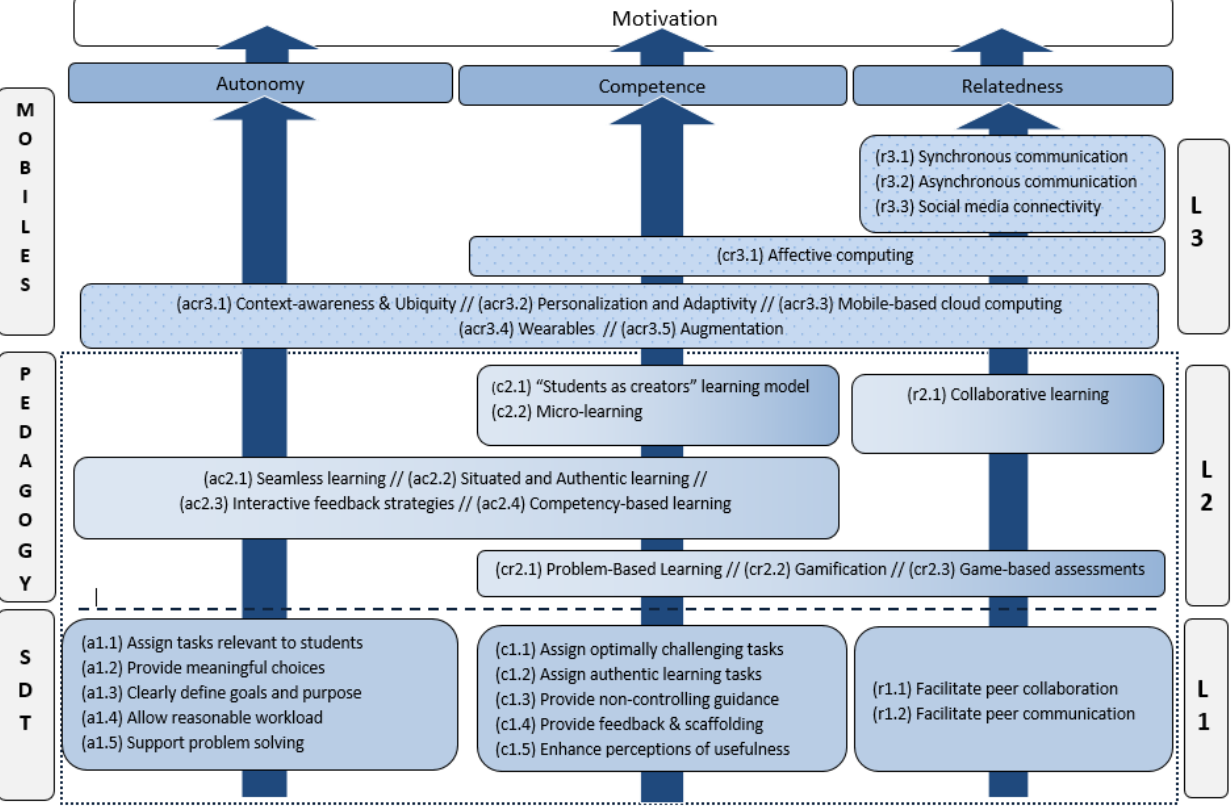
Figure 1. Formative assessment framework to enhance student motivation using mobile technologies (notation explained: (a) stands for autonomy, (c) for competence, and (r) for relatedness support, e.g., (a1.1) supports autonomy, (cr2.3) supports competence and relatedness).